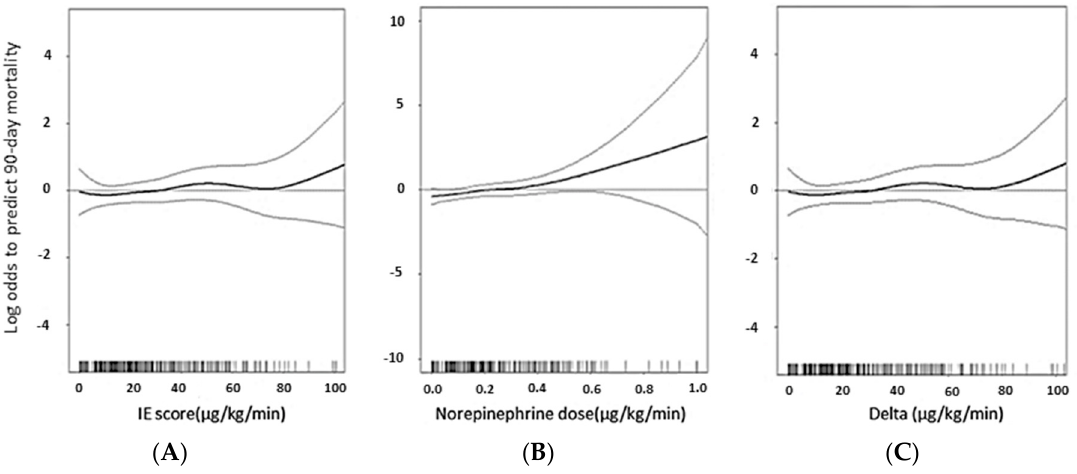
Figure 2. Generalized additive mode (GAM) plot of the probability of 90-day mortality regarding the dose equivalent of inotropes. The model incorporates subject-specific (longitudinal) random effects, expressed as the logarithm of the odd (logit). The probability of mortality was constructed with the equivalent dose of ( A ) inotropes ( B ) NE ( C ) inotropic dose deduct NE dose and was centered to have an average of zero over the range of the data as constructed with the GAM. IE: inotropic equivalent.